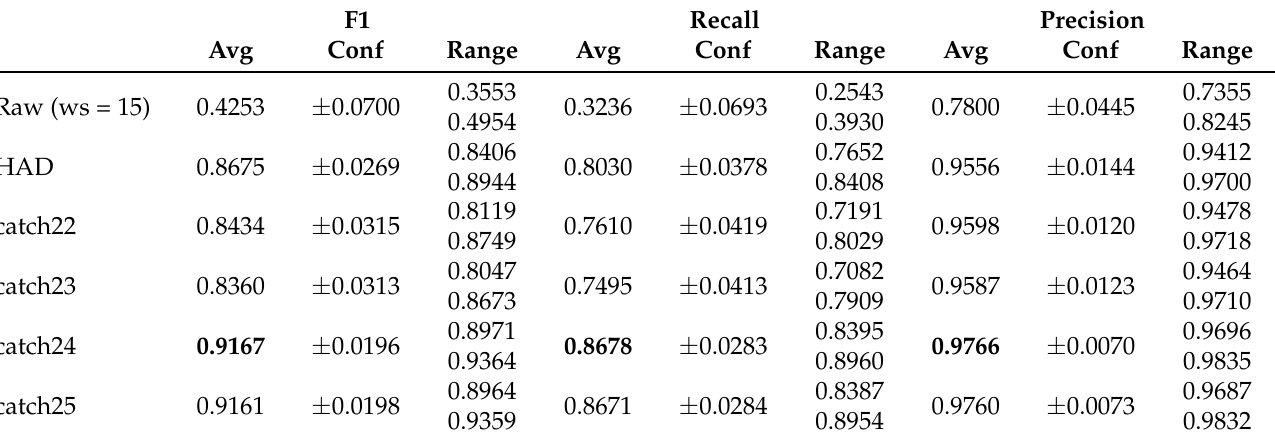
Table 6. For each feature set under test, the mean F1, recall, and precision, along with confidence intervals, were used to calculate the 95% interval (in all cases using a population of 50 samples), and range was calculated across the results for the Random Forest and Xgboost model types and dataset fold (excluding Yahoo Artificial) combinations. Bold font indicates highest score for a